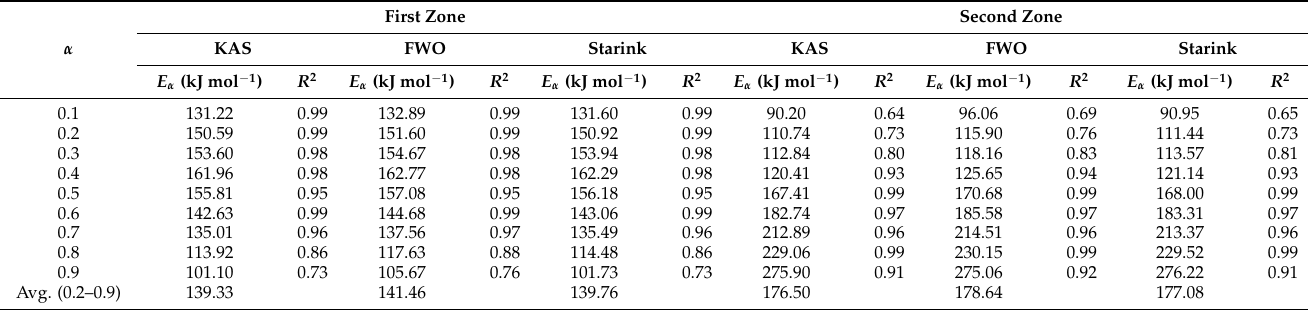
Table 8. Activation energy ( E α ) obtained by model-free methods for